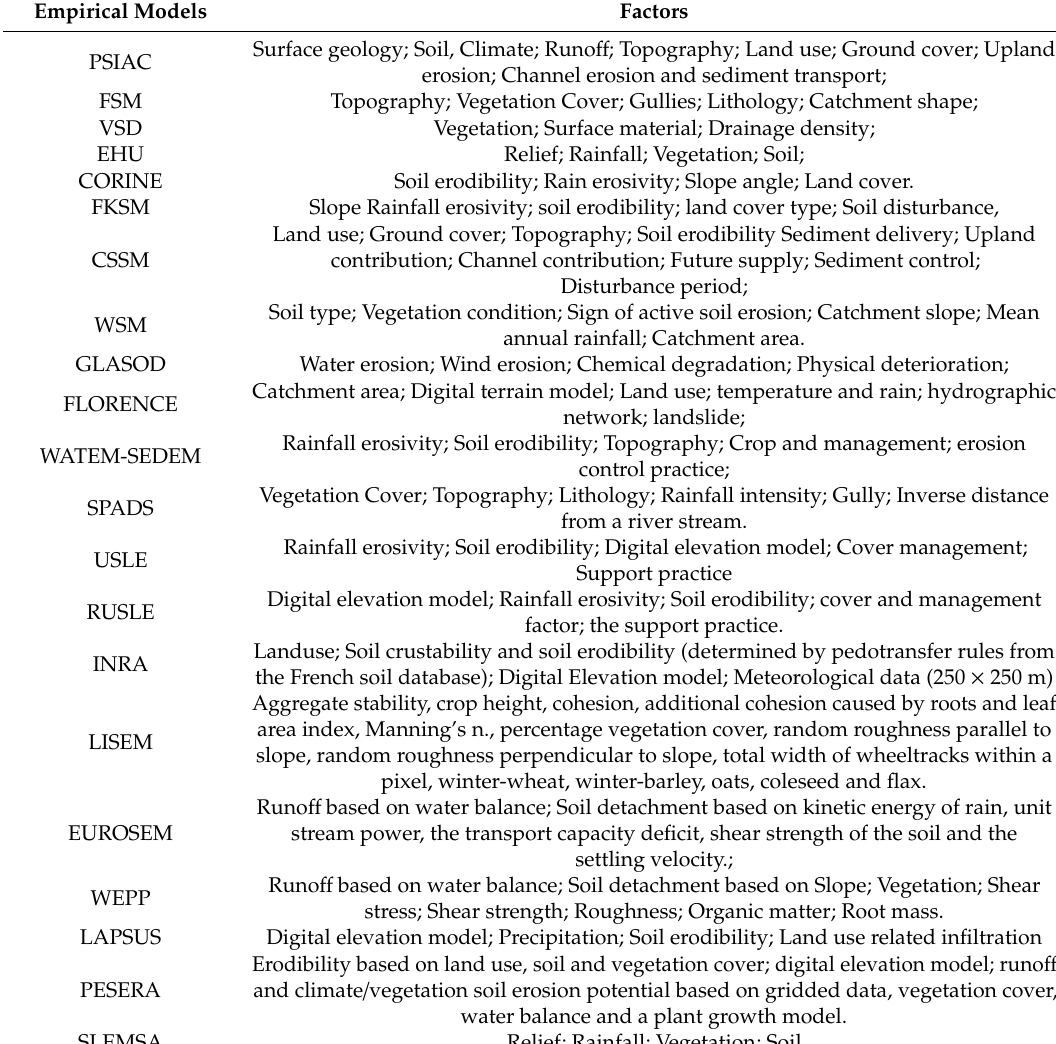
Table 1. Overview of semiquantitative model and their